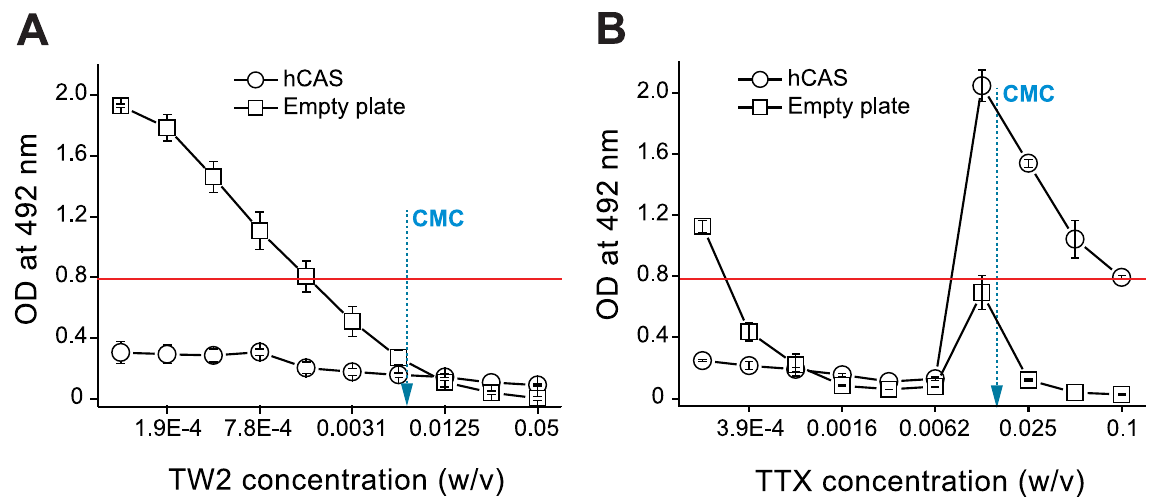
Fig 2. Influence of detergents on LPS binding to casein hydrolysate (hCAS)-blocked or empty plates. FITC-LPS isolated from E . coli serotype O111:B4 was incubated at 5 μ g/ml in PBS-EDTA (control, red line) or in PBS-EDTA supplemented with twofold dilutions of Tween 20 (TW2, A) or Triton X-100 (TTX, B), starting at concentrations of 0.05 and 0.1% (w/v) respectively. Samples were tested in triplicate (mean values ± SD). CMC: critical micelle concentration (0.0074 and 0.0155% w/v, for TW2 and TTX,